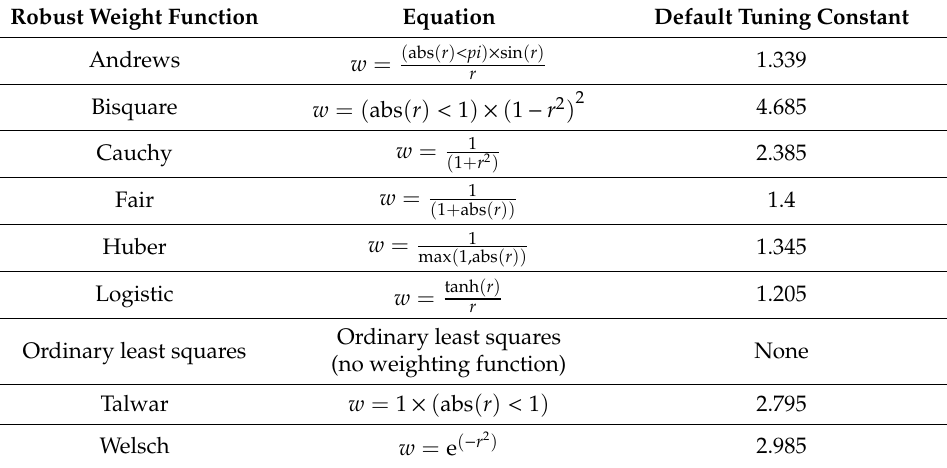
Table 2. Robust Weight